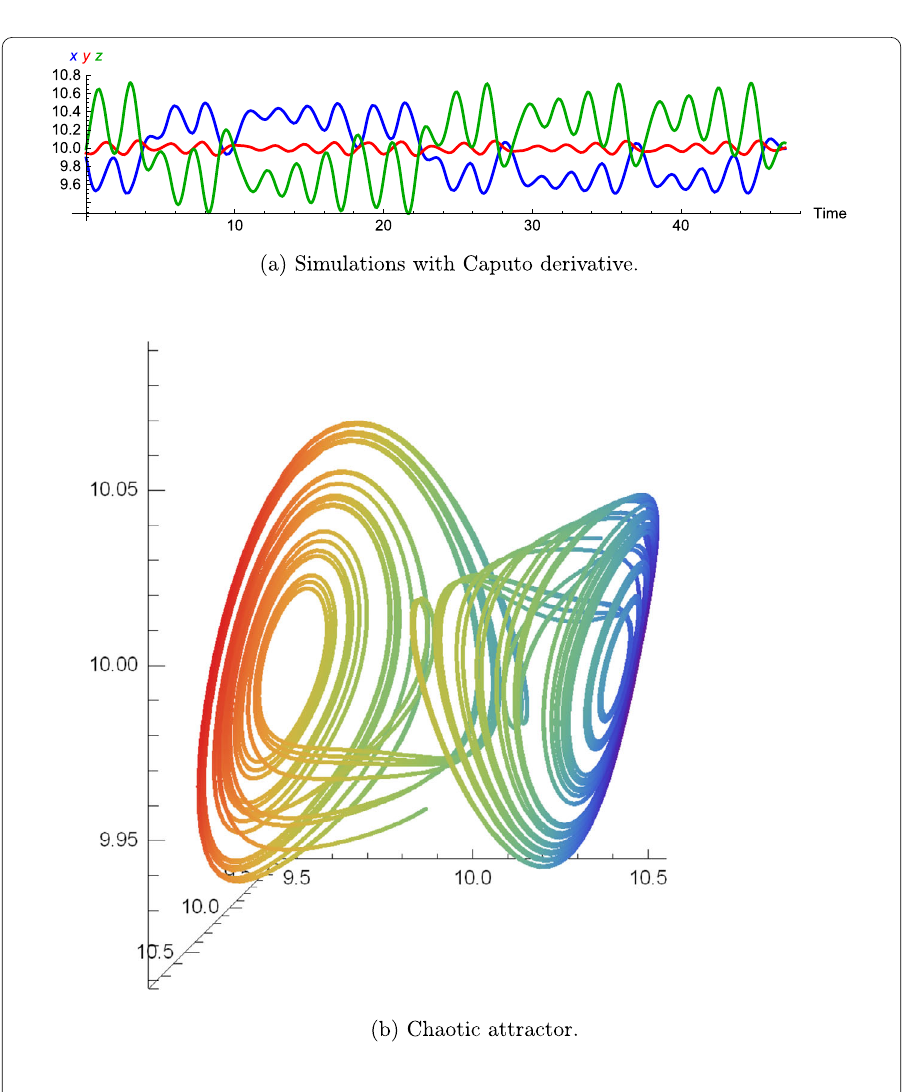
Figure 2 OPIM – C solutions of the modified Chua’s circuit in Example